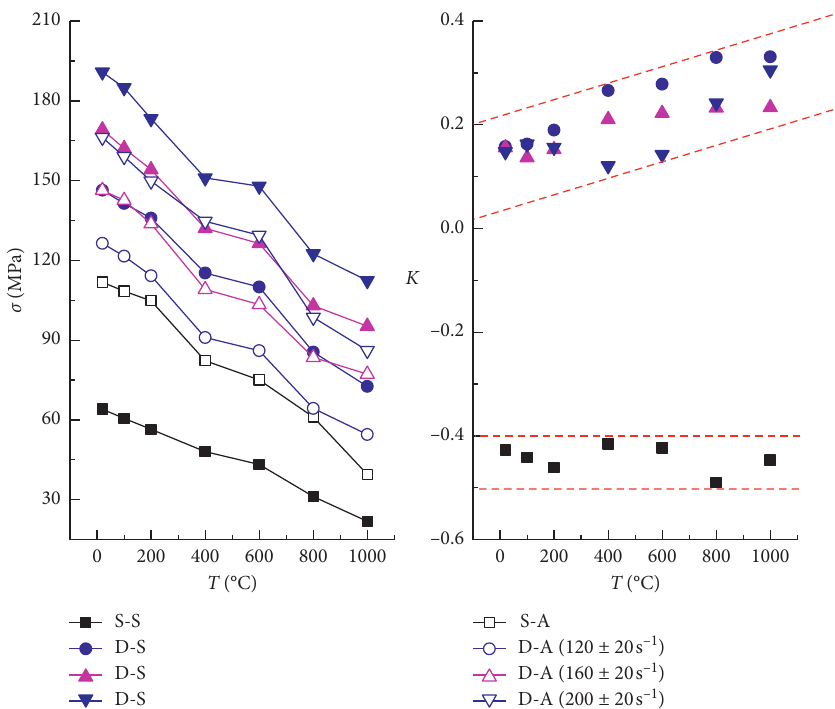
Figure 7: Static and dynamic strengths of argillaceous sandstone under different test conditions.